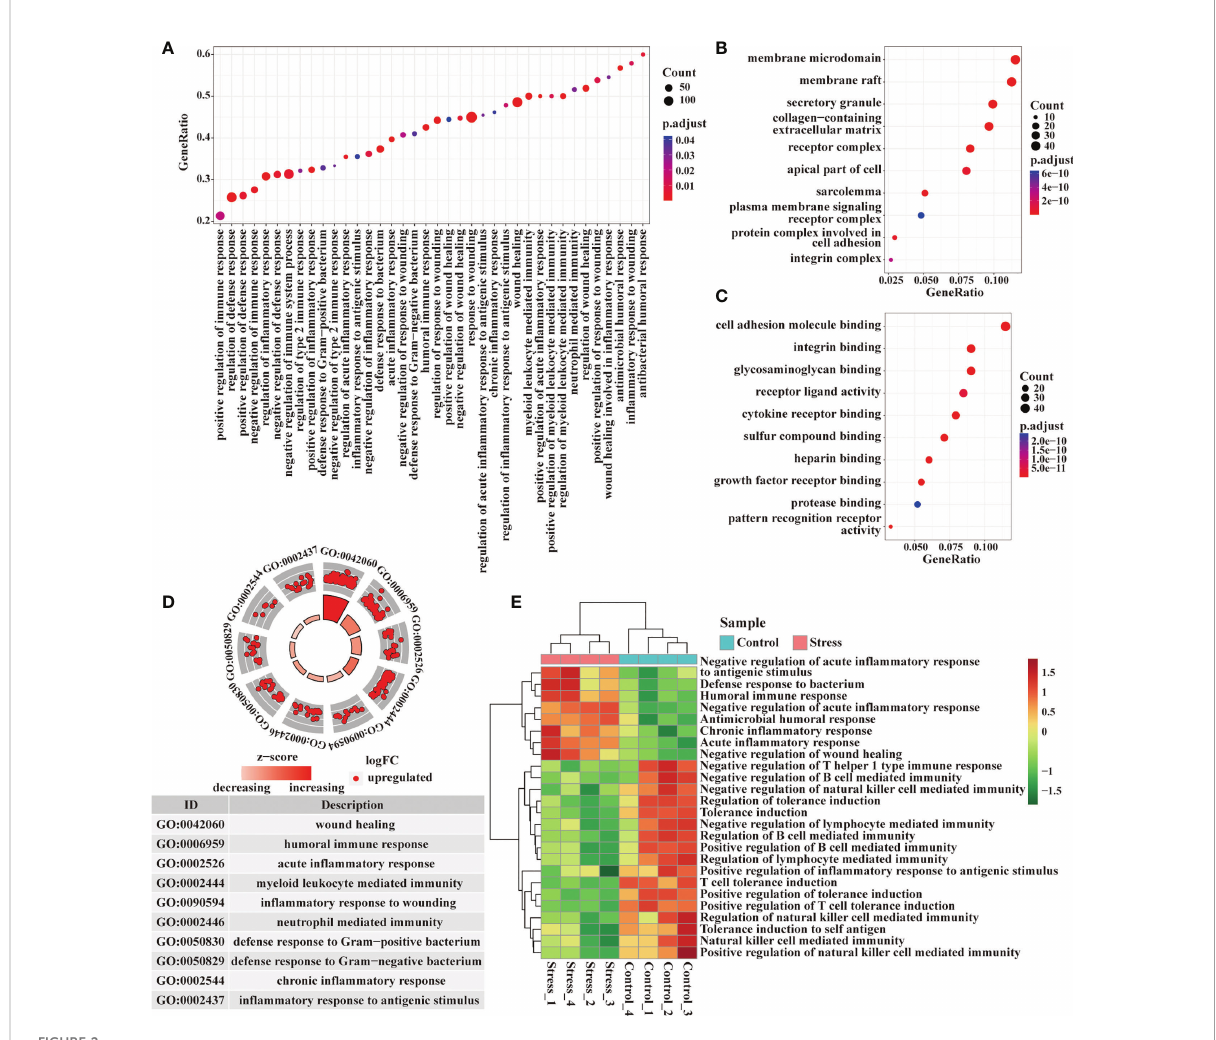
FIGURE 2 Analysis of gene expression at immune response level by GSEA and GSVA. (A) GO enrichment analysis of the whole transcriptome was performed by GSEA, and the biological processes represented by the gene terms were visualized at the immune response level. (B, C) Genes from these gene terms were selected for another GO enrichment analysis, and the top 10 CC and MF were visualized. (D) Select some important gene terms related to immune response, and then visualize the gene expression. (E) Meanwhile, GSVA was performed on RNA-seq, and the differentially expressed gene terms were visualized at the immune response